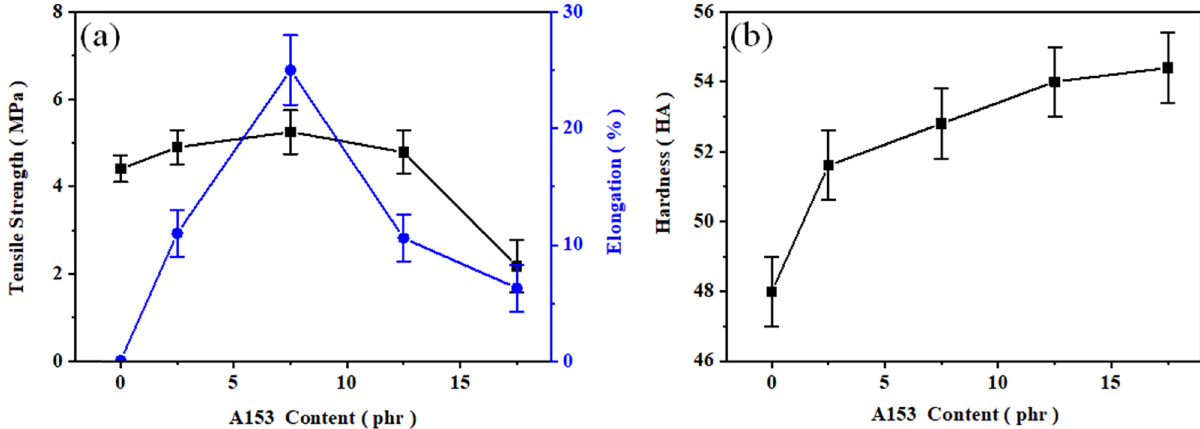
Figure 2: E ff ect of di ff erent content of A153 on mechanical properties of PP composites: ( a ) elongation at break and tensile strength and ( b )